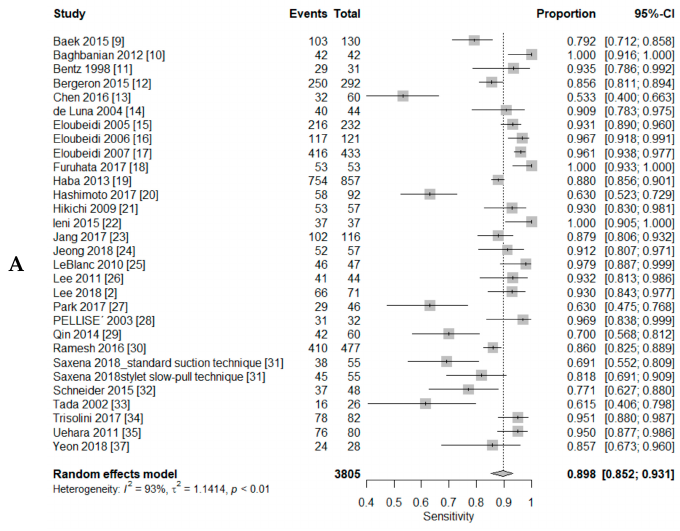
Table 2. Diagnostic accuracy in endoscopic ultrasonography-guided fine-needle aspiration according to the cytologic